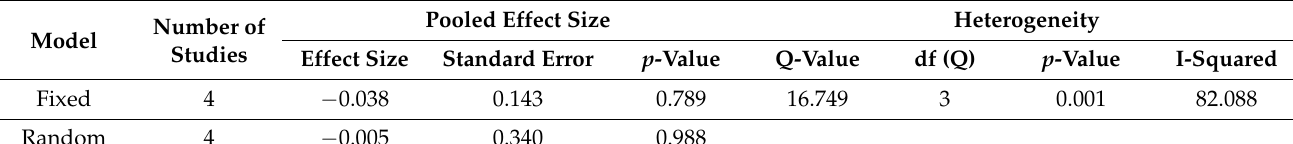
Table 15. Heterogeneity test results of studies on the influence of indoor plants on attention.